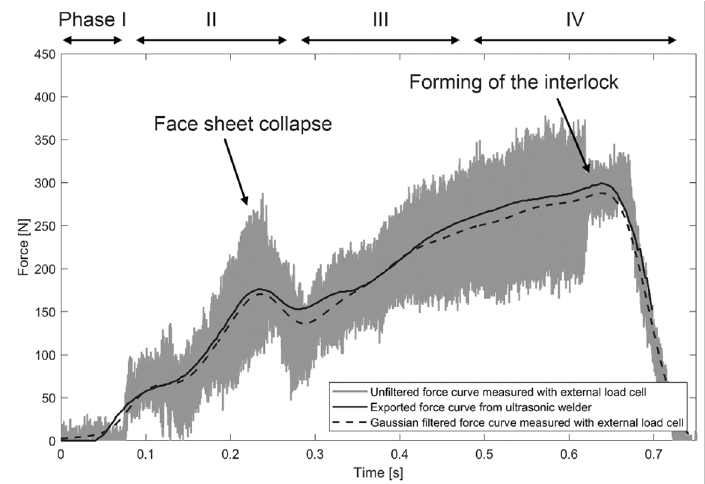
Figure 3. Comparison of force curves derived from different sensor data.